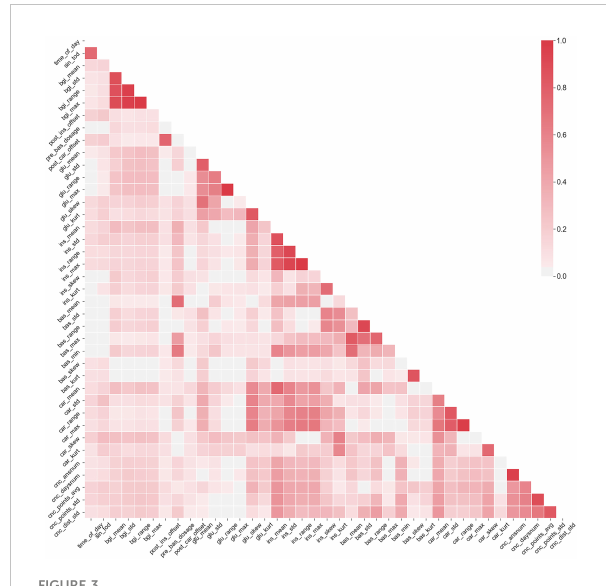
FIGURE 3 The correlation matrix of features that have exhibited r ≥ 0.7 with at least one other feature. Color scale denotes the correlation between the variables.